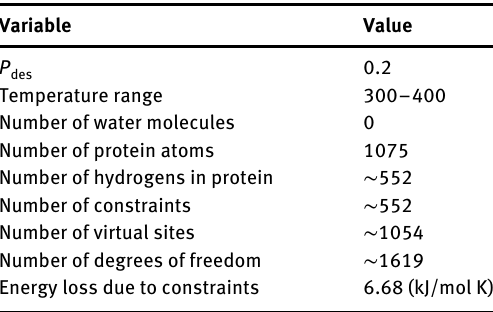
Figure 6: Aligned POTEE structures – DNN-predicted POTEE model (blue) aligned with Swiss-Model POTEE structure (red). The perfectly aligned regions have been represented in surface representation. Table 4: Important factors for running REMD